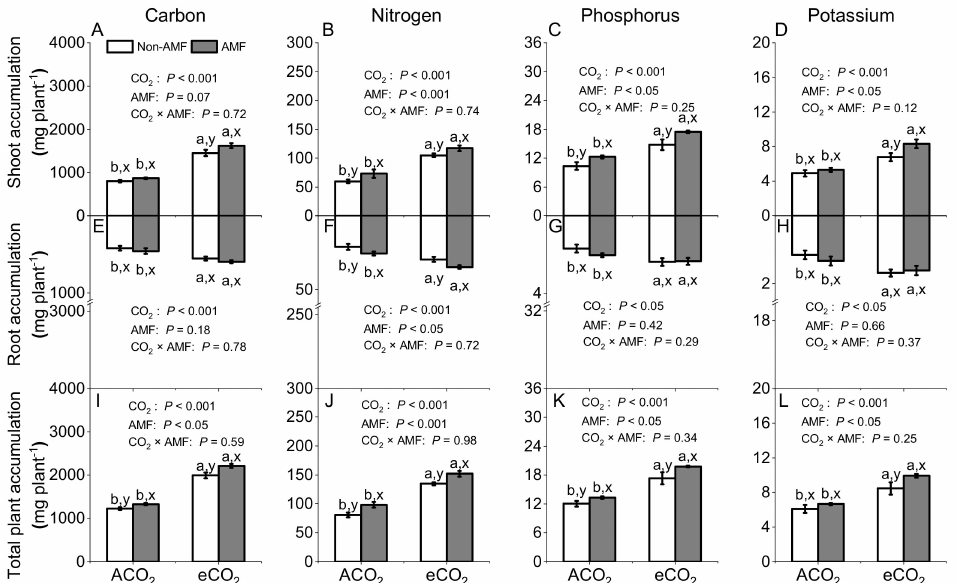
Figure 2. Accumulations of carbon ( A , E , I ), nitrogen ( B , F , J ), phosphorus ( C , G , K ), and potassium ( D , H , L ) in shoots, roots, and total plants of Funneliformis mosseae inoculated faba beans grown for 12 weeks at ambient CO 2 (ACO 2 ) and elevated CO 2 (eCO 2 ). Data (means ± SE, n = 3) followed by different letters indicate significant differences between CO 2 treatments for the same AMF inoculation (a, b) and between AMF inoculations for the same CO 2 treatment (x, y) at P < 0.05 as revealed by Tukey’s test. Statistical comparisons (two-way ANOVA) between AMF or CO 2 treatments as well as their interaction (AMF × CO 2 ) are presented for each